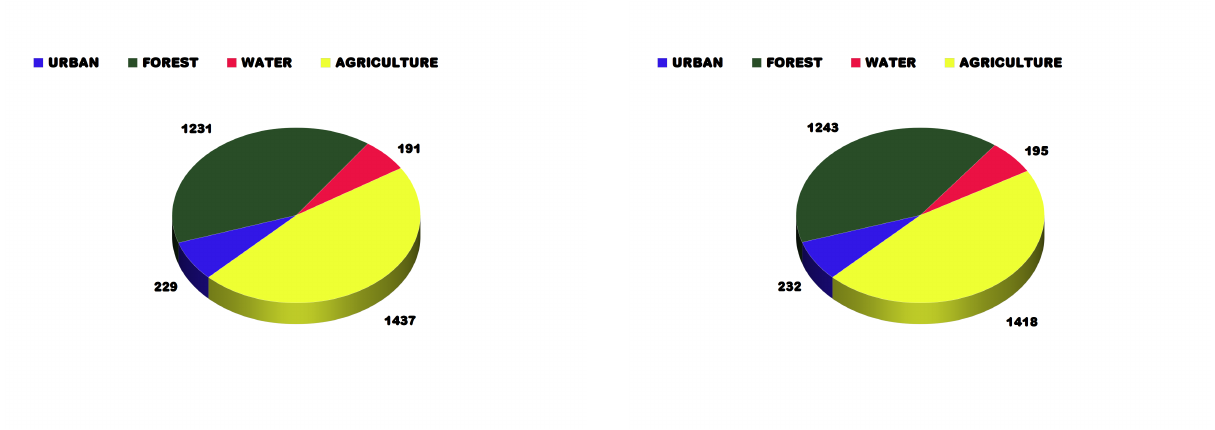
Figure 8: Area of each landcover classes by GTB